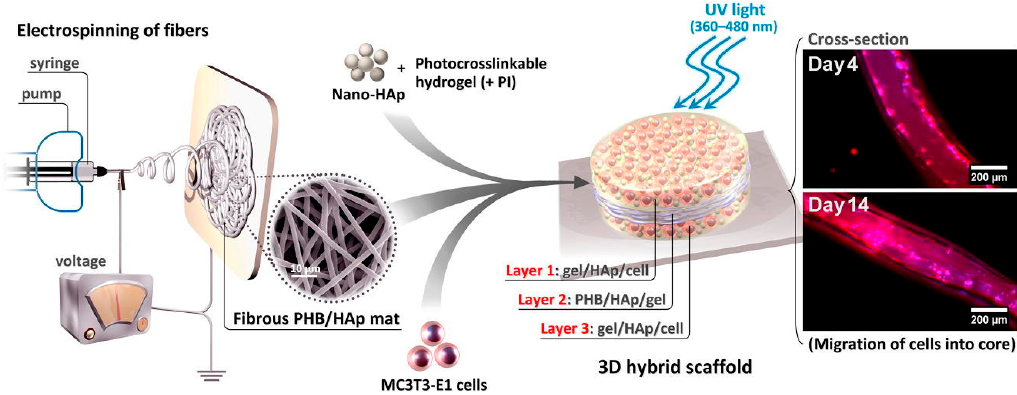
Figure 4. Schematic overview of the method to fabricate 3D cell-laden laminated